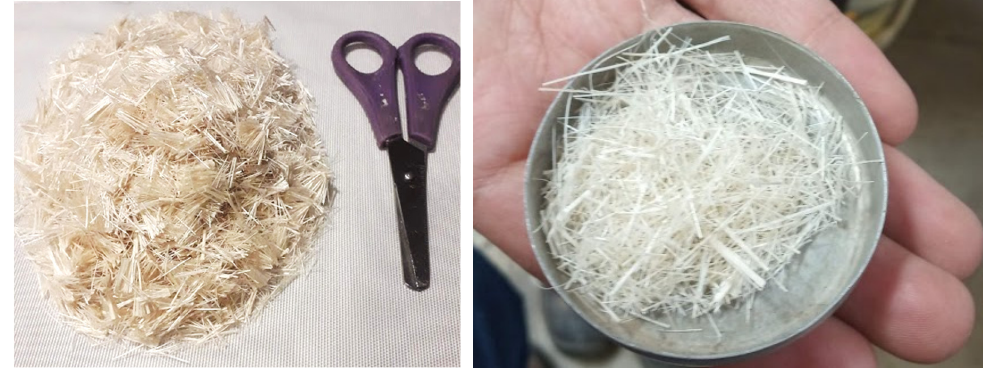
Table 2. Physical and mechanical properties of the fiber.